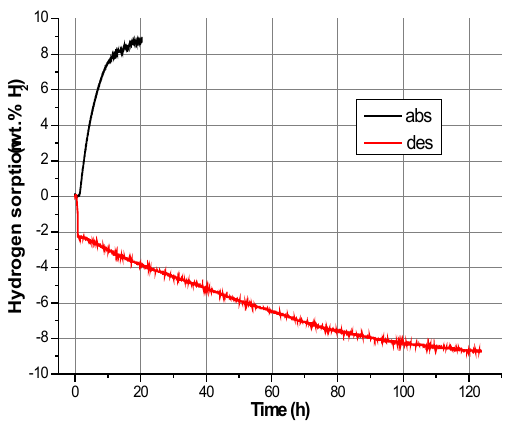
Figure 7. Hydrogen sorption for LiH–MgB Conditions for absorption and desorption were 350ºC at 50 bar H and 380ºC at 5 bar H 2